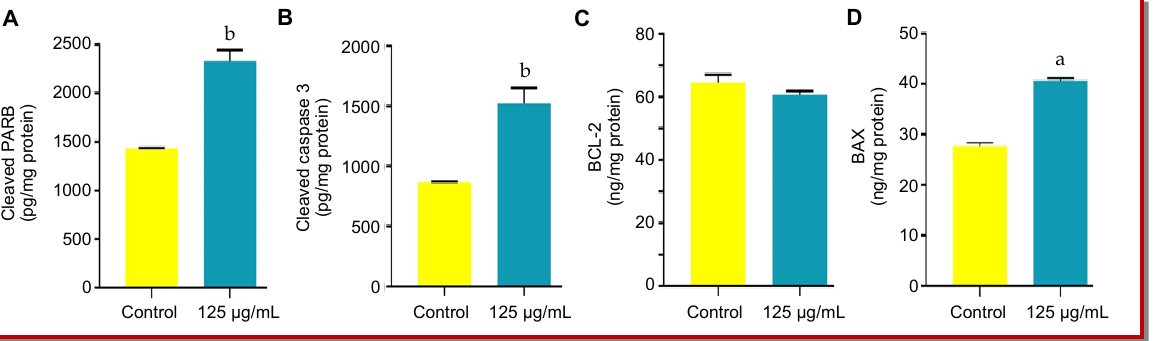
Figure 2: β -glucan (125 μ g/mL) enhanced apoptosis of SH-SY5Y cells. The cleaved caspase 3, BCL-2, cleaved PARP and Bax levels were calculated using the ELISA kits. Results are represented as mean ± SEM of three samples. a p< 0.01 and b p<0.05 as compared to the control